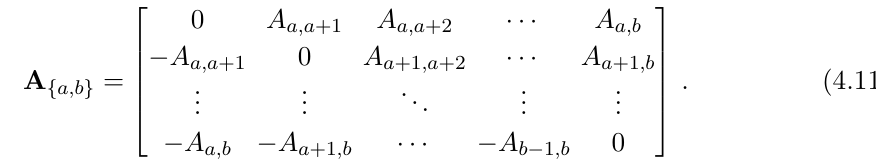
, i.e. when we remove row and column 1. n